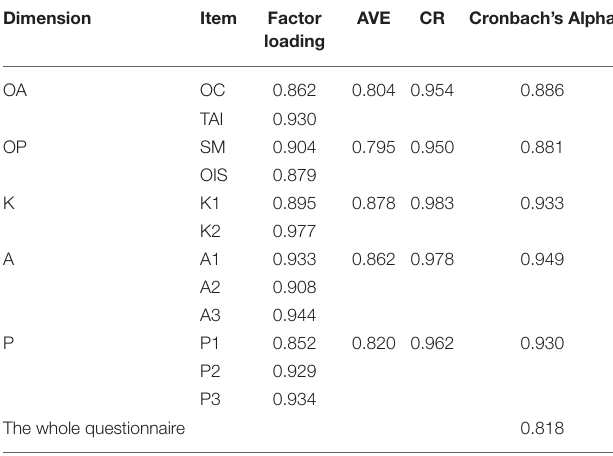
TABLE 2 | Results of confirmatory factor analysis. Dimension